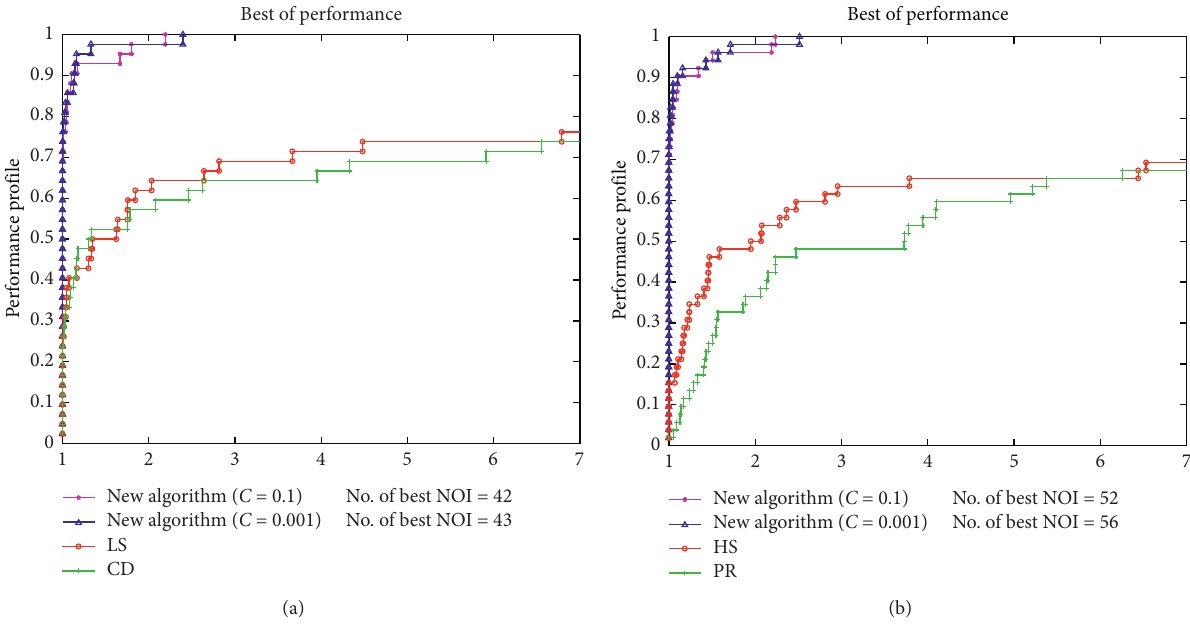
Figure 4: Performance profiles based on the best NOI. (a) Comparison of the new algorithm vs. LS and CD. (b) Comparison of the new algorithm vs. HS and